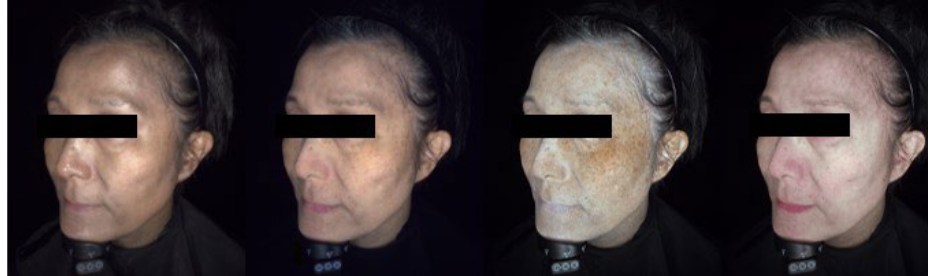
Figure 4. A 50-year-old female experienced progressively darkening skin after applying essential oil for two years. The skin diagnosis system reveals irregular brown to gray hyperpigmentation over cheeks and forehead under room light. Cross-polarized light enhances the hyperpigmented area. True UV light significantly highlights the dyschromic regions. Erythema can be observed over lesional skin, suggesting subclinical inflammation of the skin. (From left to right: room light mode; cross-polarized light mode, UV mode, erythema mode, OBSERV ® 520× skin diagnosis system) .